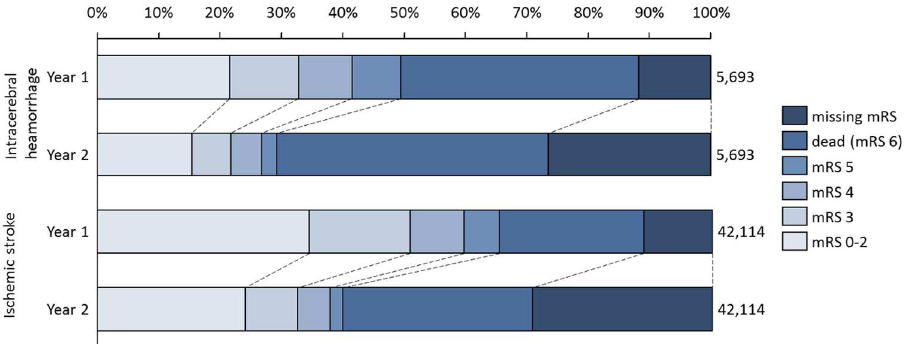
Fig 1. Distribution over mRS categories and missing mRS assessment during first and second year,